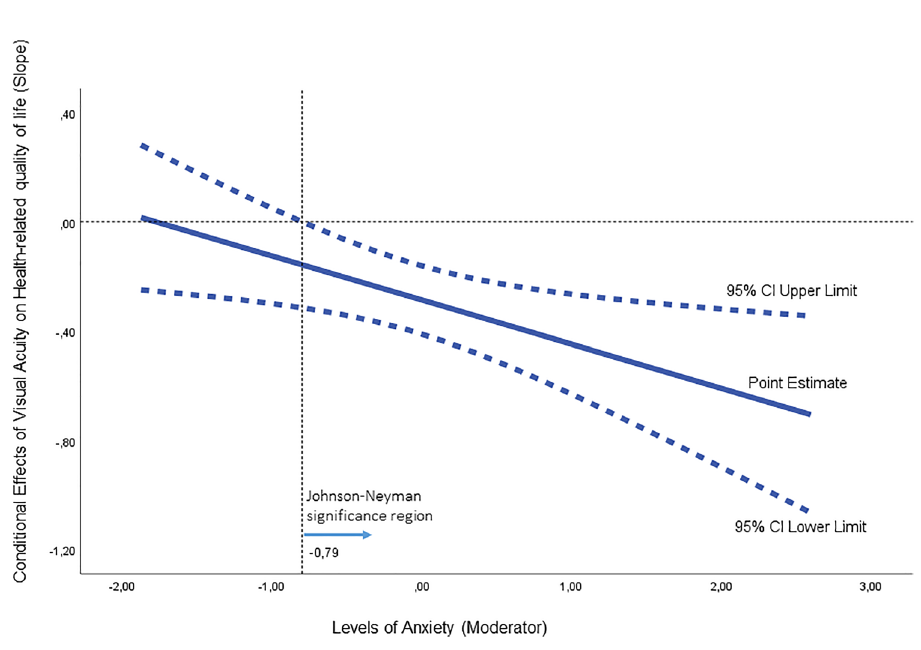
Figure 3. Johnson-Neyman plot depicting conditional effects of visual acuity on change within health-related quality of life at values of the moderator anxiety. The range of observed values of anxiety is [− 0.93,